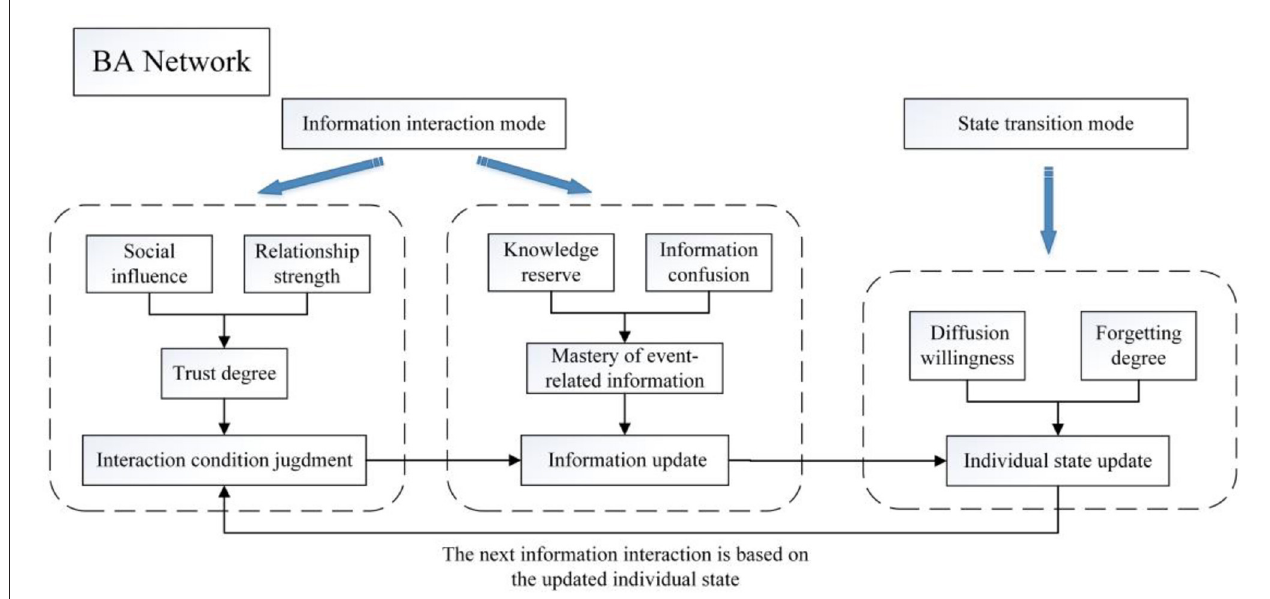
FIGURE 4 | Construction of SEIR-OM